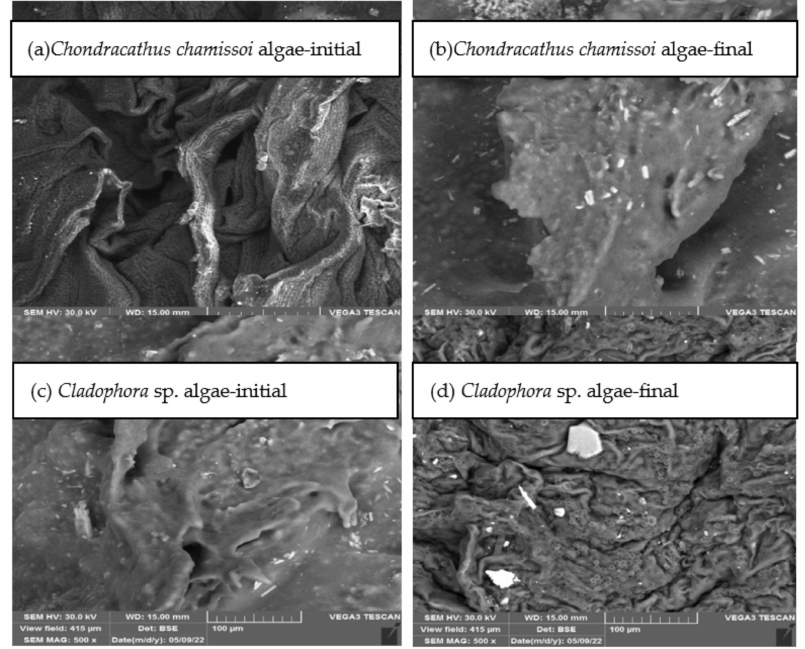
Figure 5. Micrographs of the algae Chondracathus chamissoi and Cladophora sp. initial and final observed by scanning electron microscopy